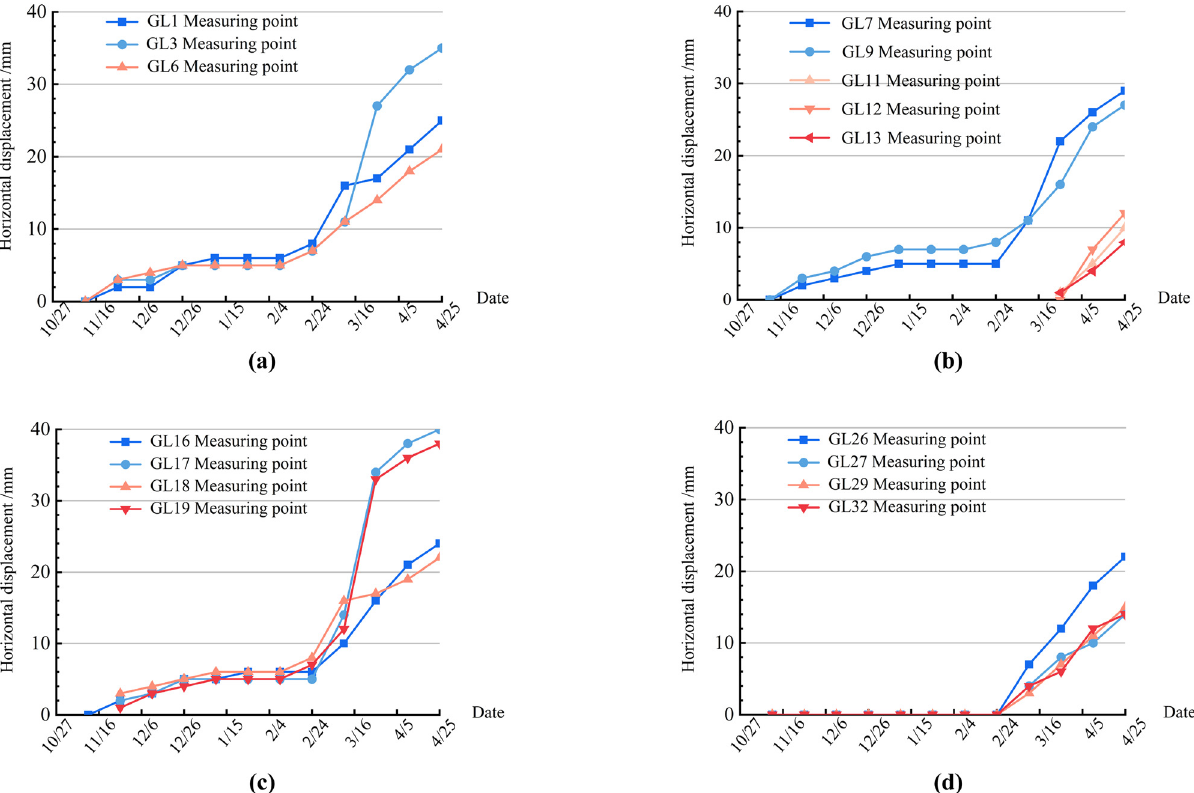
Figure 4: Horizontal displacement diagrams of the crown beam top. ( a ) East side, ( b ) south side, ( c ) west side, and ( d ) north